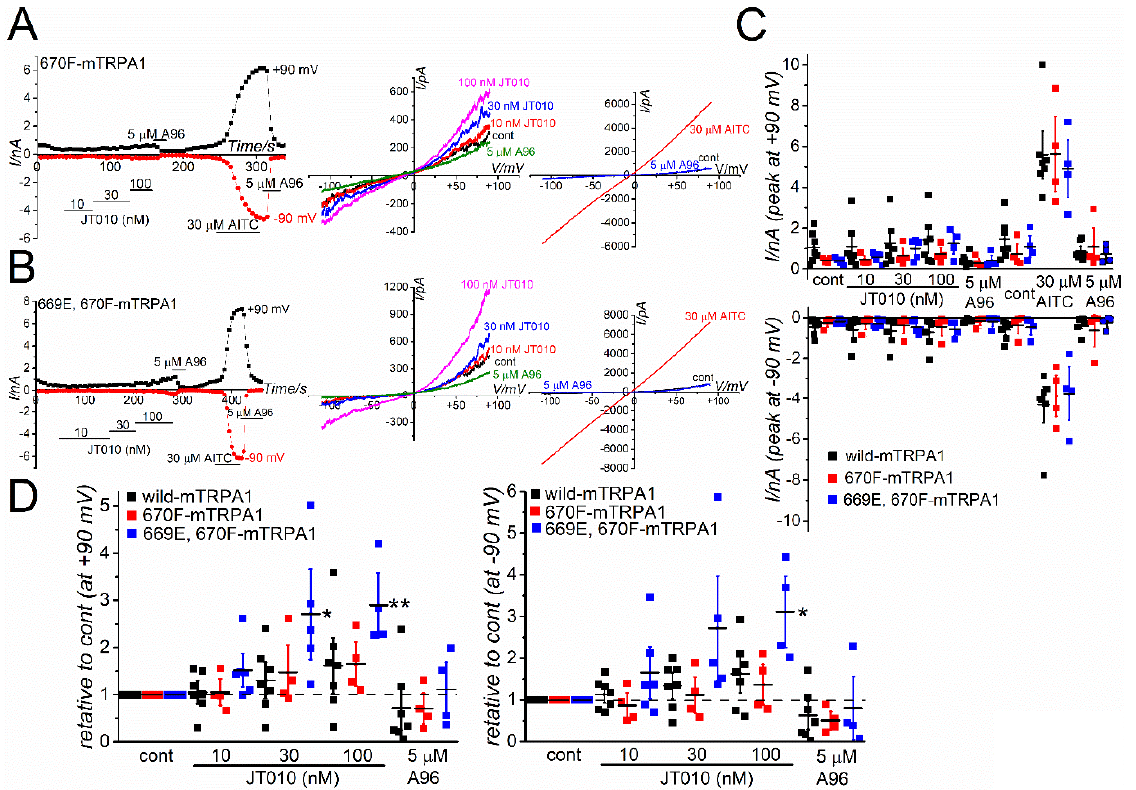
Figure 6. S669 and M670 are the potential amino acids that determine the low sensitivity of mTRPA1 to JT010. Cells were superfused with SBS without Ca 2+ and dialyzed with a Cs-aspartate-rich pipette solution including 0.3 μ M Ca 2+ . Ramp waveform voltage pulses from − 110 to +90 mV for 300 ms were applied every 5 s. (A-B) JT010 was commutatively applied to HEK cells with an M670F substitution in mTRPA1 ( A , 670F-mTRPA1) and double substitutions of S669E and M670F ( B , 669E, 670F-mTRPA1) to examine the effects on membrane currents at − 90 and +90 mV, and the pooled data of the peak currents evoked are summarized ( C , four to six independent experiments including the same data set as in Figure 2F). After applying 100 nM JT010, 5 μ M A96 was added to block the TRPA1 channel current components. For comparison, 30 μ M AITC was used. In the middle and right panels of ( A , B ), the I-V relationships under each experimental condition are shown. ( D ) Each current amplitude shown in ( C ) was normalized to that of the control without JT010 and exhibited the relative amplitude change under each treatment. Dunnett’s multiple comparisons test was performed for each TRPA1 gene. * p = 0.0116 and ** p = 0.00829 for 30 and 100 nM JT010, respectively in 669E, 670F-mTRPA1 (+90 mV). * p = 0.0327 for 100 nM JT010 in 669E, 670F-mTRPA1 ( − 90 mV). Vertical bars = SEM.